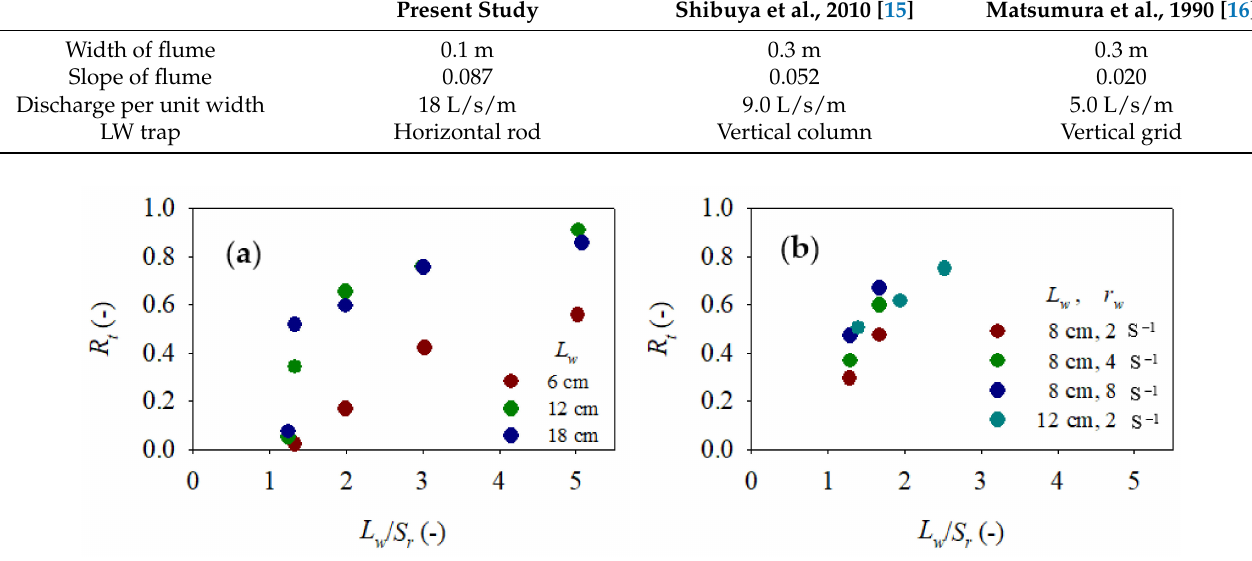
Figure 13. Experimental relationship between the relative length of LW with respect to the horizontal rod spacing ( L w / S r ) and the trapping rate ( R t ) ( a ): Shibuya et al., 2010, ( b ): Matsumura et al., 1990 (both figures are modified by the authors).